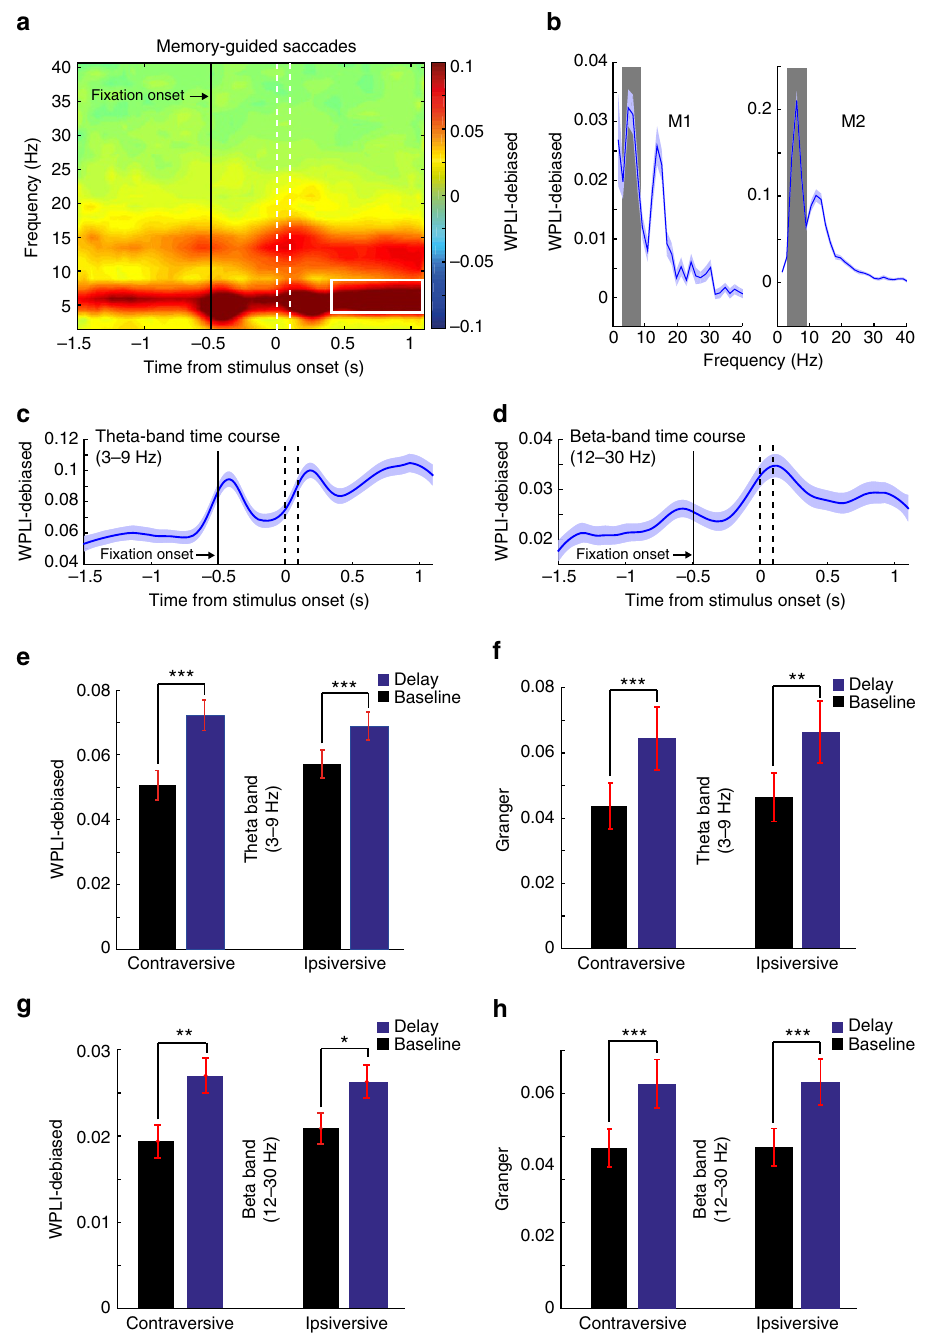
Figure 3 | Increased theta and beta coherence between ACC and FEF. ( a ) Time-frequency spectrum of the WPLI-debiased coherence between the FEF and ACC in memory-guided saccade task for the population of ACC-FEF channel pairs ( n ¼ 674). The white contour shows the area in which the subsequent analyses were performed (see Methods). The dashed lines demarcate the time of the onset and offset of the target stimulus. ( b ) WPLI-debiased FEF-ACC coherence spectrum of the individual monkeys in the delay period across all recording pairs ( n ¼ 674). ( c ) Theta-band (3–9Hz) time course of the ACC-FEF WPLI-debiased phase synchronization. ( d ) Beta-band (12–30Hz) time course of the ACC-FEF WPLI-debiased phase synchronization. ( e ) Comparison of WPLI-debiased coherence between baseline and delay period of the contra- and ipsiversive memory-guided saccades (*** P o 0.001, t -test). Error bars indicate s.e.m. ( f ) Comparison of the overall Granger-causality influence of ACC over FEF (GACC - FEF (cid:2) GFEF - ACC) between baseline and delay period of the contra- and ipsiversive memory-guided saccades (*** P o 0.001, ** P o 0.01, t -test, n ¼ 275). Error bars indicate s.e.m. ( g ) Comparison of beta-band WPLI-debiased coherence between baseline and delay period of the contra- and ipsiversive memory- guided saccades (** P o 0.01, * P o 0.05; t -test). Error bars indicate s.e.m. ( h ) Comparison of the beta-band overall Granger influence of ACC over FEF (GACC - FEF (cid:2) GFEF - ACC) between baseline and delay period of the contra- and ipsiversive memory-guided saccades (*** P o 0.001; t -test). Error bars indicate